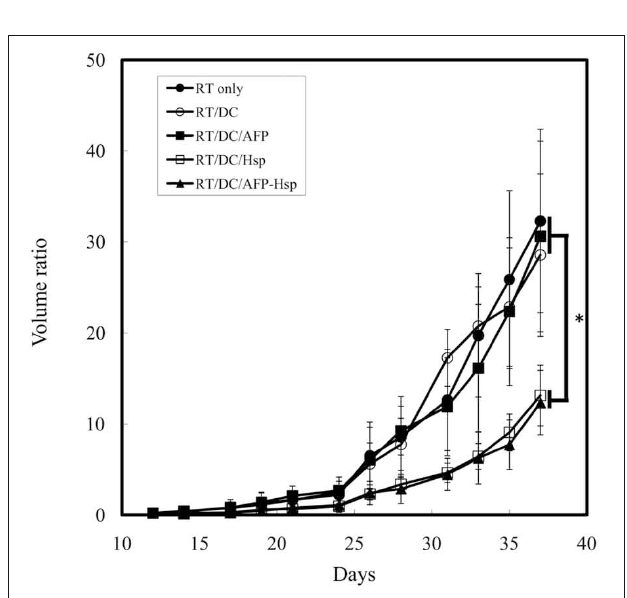
FIGURE 4 | Tumor growth inhibition assay in rHsp70/rAFP model. Mice were injected with 1 × 10 5 CT26/AFP tumor cells s.c. on day 0 and treated with 8Gy of RT on day 14 followed by immunotherapy in different groups. Each treatment group included 6 mice. Mean volume ratio, with SD for each group, is plotted vs. days after tumor-cell inoculation. ∗ Indicates p < 0 . 05.